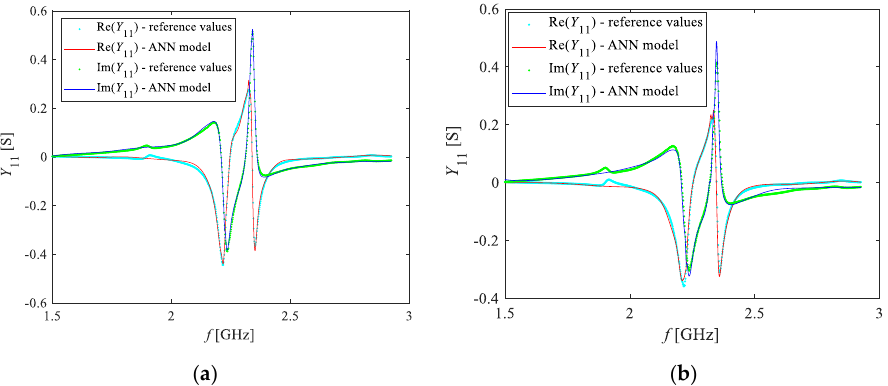
Figure 11. Frequency dependence of the real and imaginary parts of Y 11 at two different values of the O 2 concentration (symbols-measurements, lines-ANN simulations): ( a ) training concentration of 40%; ( b ) test concentration of 15%.